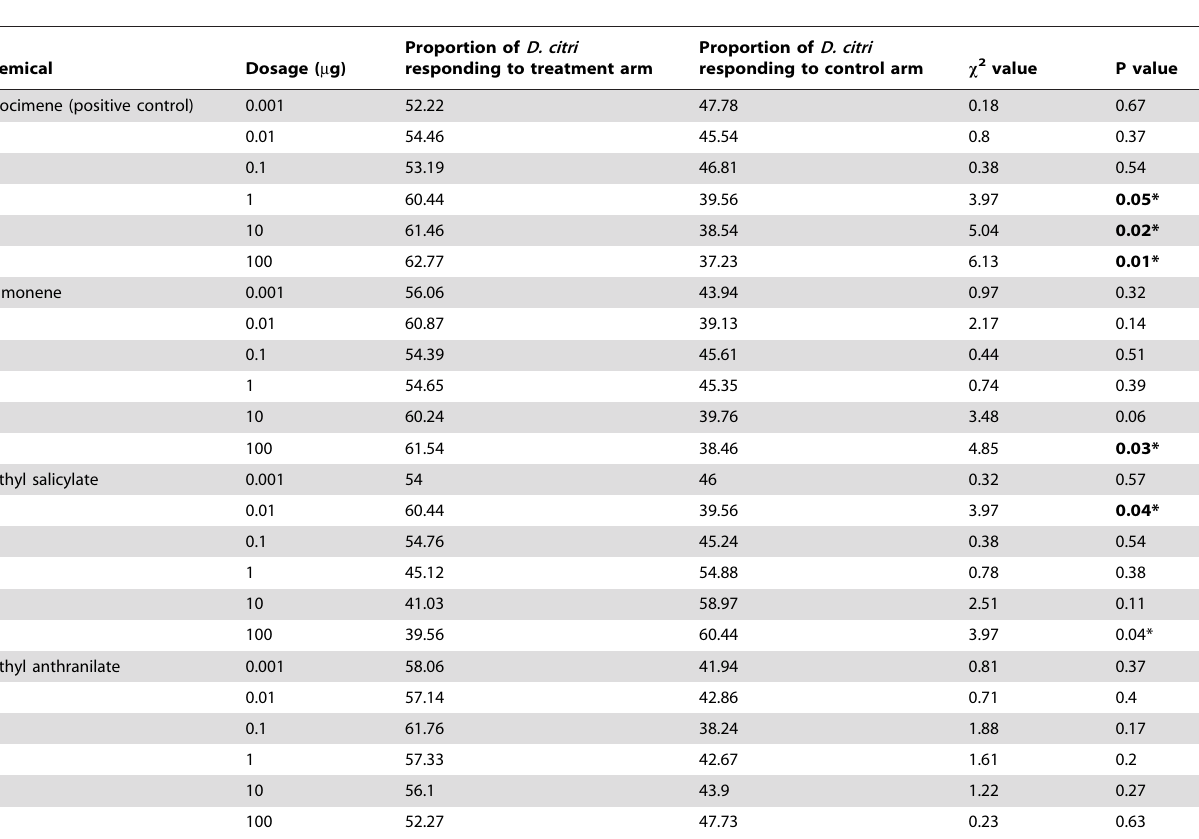
Table 4. Responses of Diaphorina citri when assayed with synthetic volatiles identified from Las-infected and non-infected citrus plants.